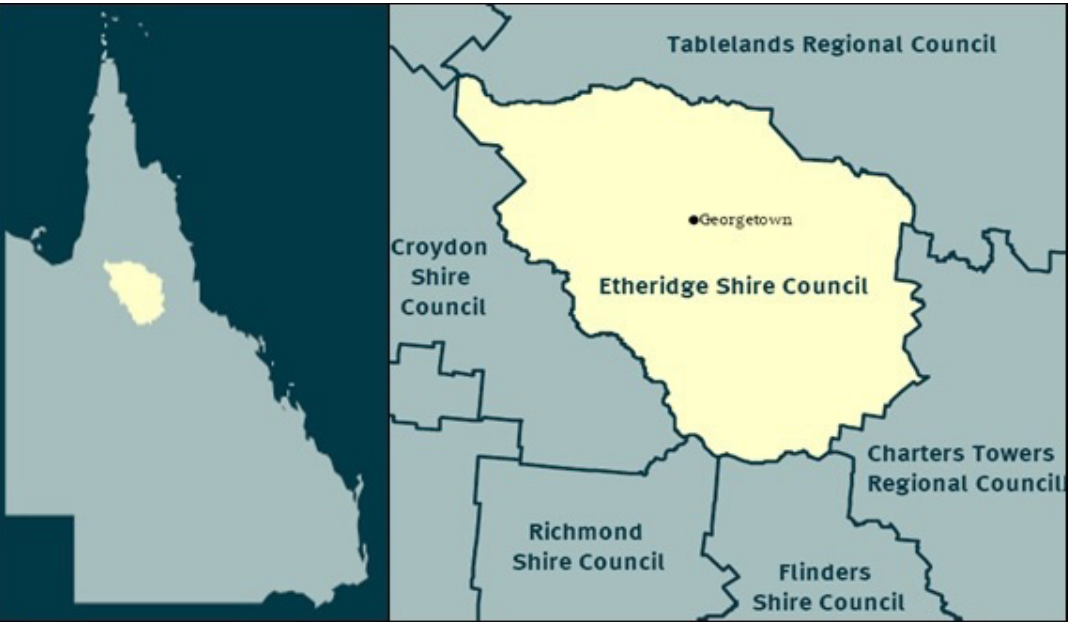
Figure 4. Etheridge Pre-Aspiring UNESCO Global Geopark area comprising Etheridge Shire, Far North